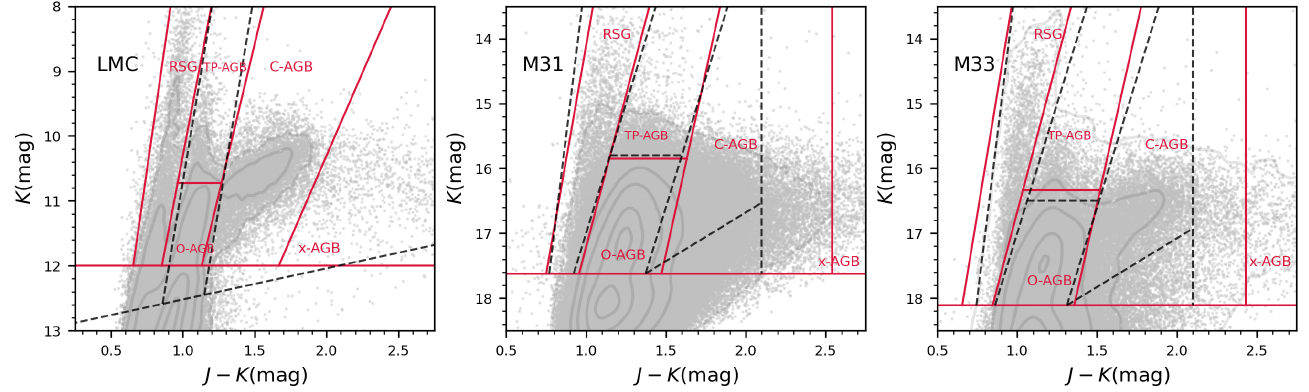
Figure 4. Comparison of the borderlines with previous studies, where the red solid lines represent this work and the grey dashed lines represent the work by Cioni et al. [67] for the LMC and by Paper I for M31 and